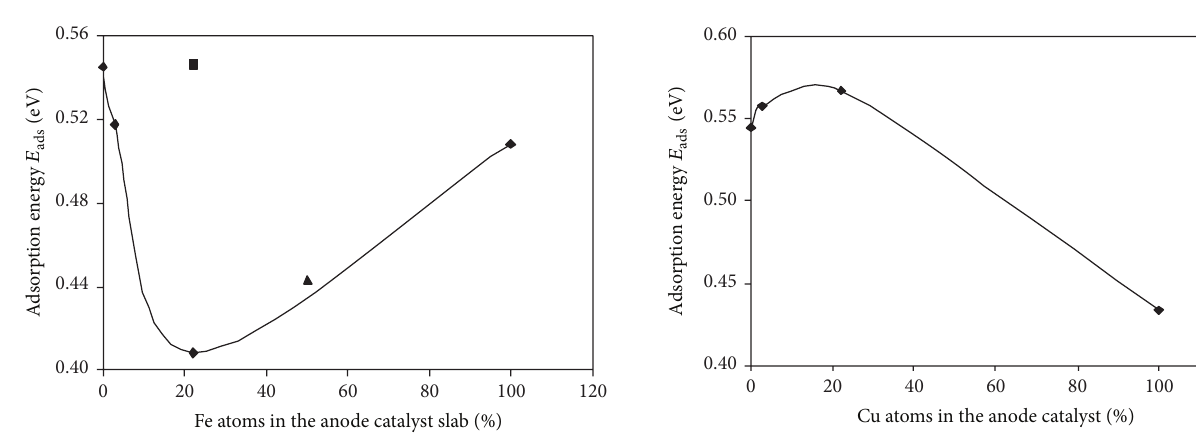
Figure 3: DFT calculated adsorption energies of propane on the surface of Ni/Cu alloy slab with various compositions (0% Cu, 2.8% Cu, 22.2% Cu, and 100%